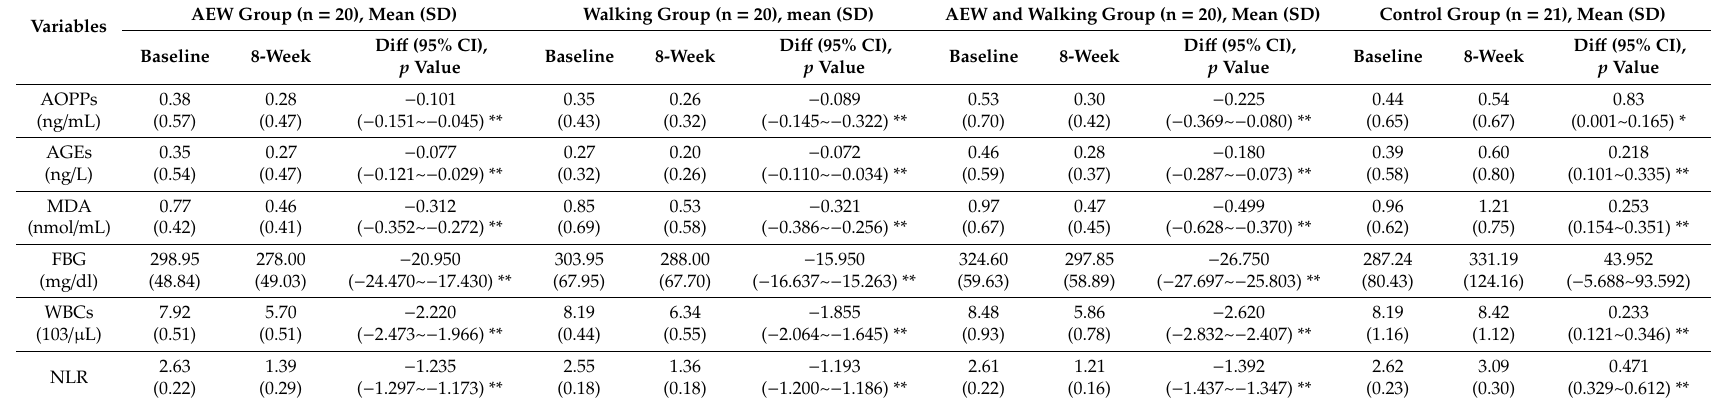
Table 3. Oxidative stress and inflammatory biomarkers before and after the intervention in participants with type 2 diabetes mellitus ( n = 81).